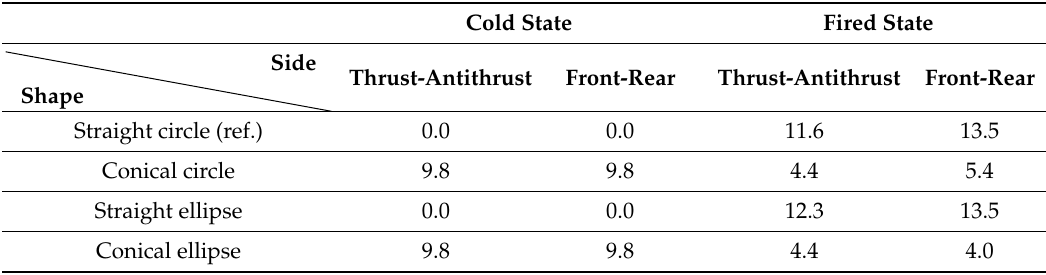
Table 2. Parallelism deviation in the axial direction for the liner in both the cold state and under typical fired operational conditions. (Numbers are given in micrometers).